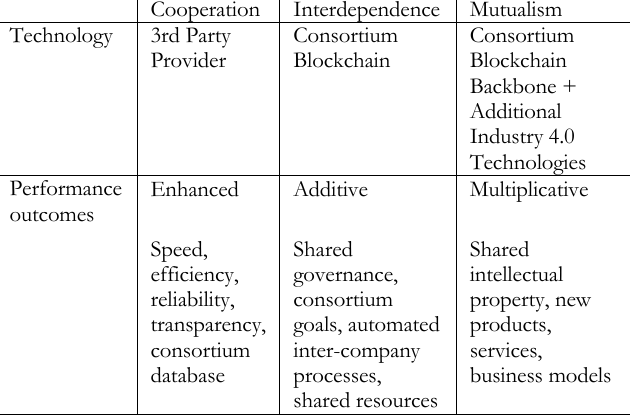
Table 1. The Blockchain Collaboration Continuum